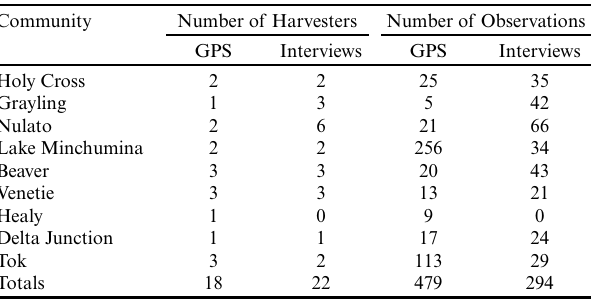
Table 3 . Numbers of harvesters and GPS/interview observations documented for each collaborating community.